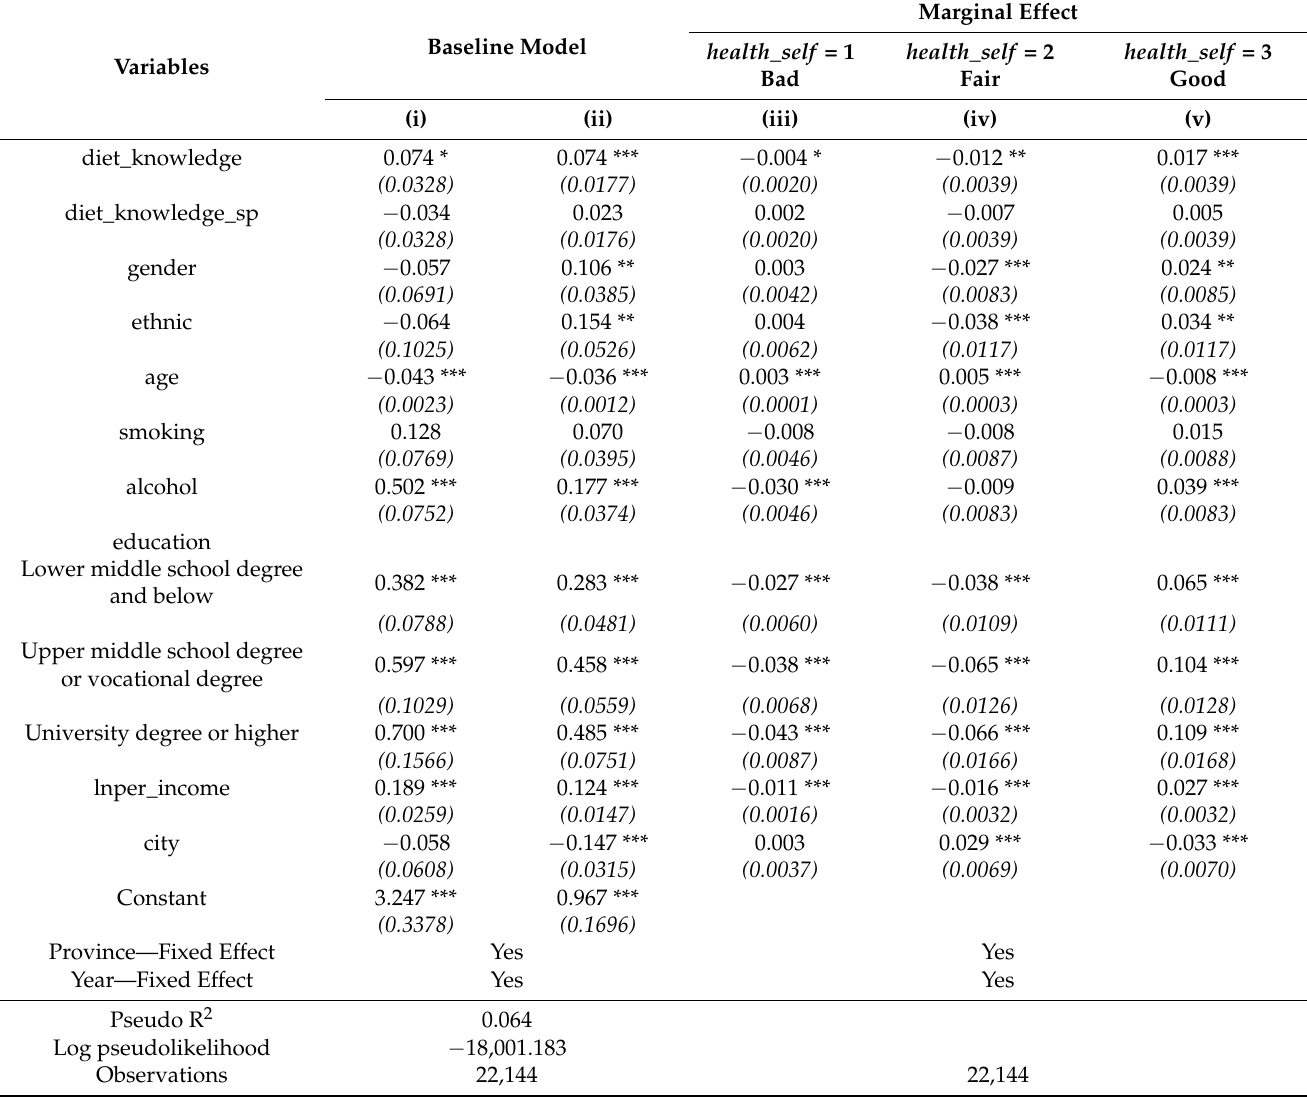
Table 3. Estimation results of the effect of spouse’s dietary knowledge on health based on the generalized ordinal logit model.